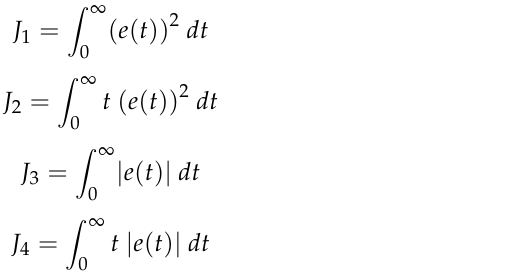
Table 1. Literature of FOPID controller design using optimization algorithms for power system applications. Reference